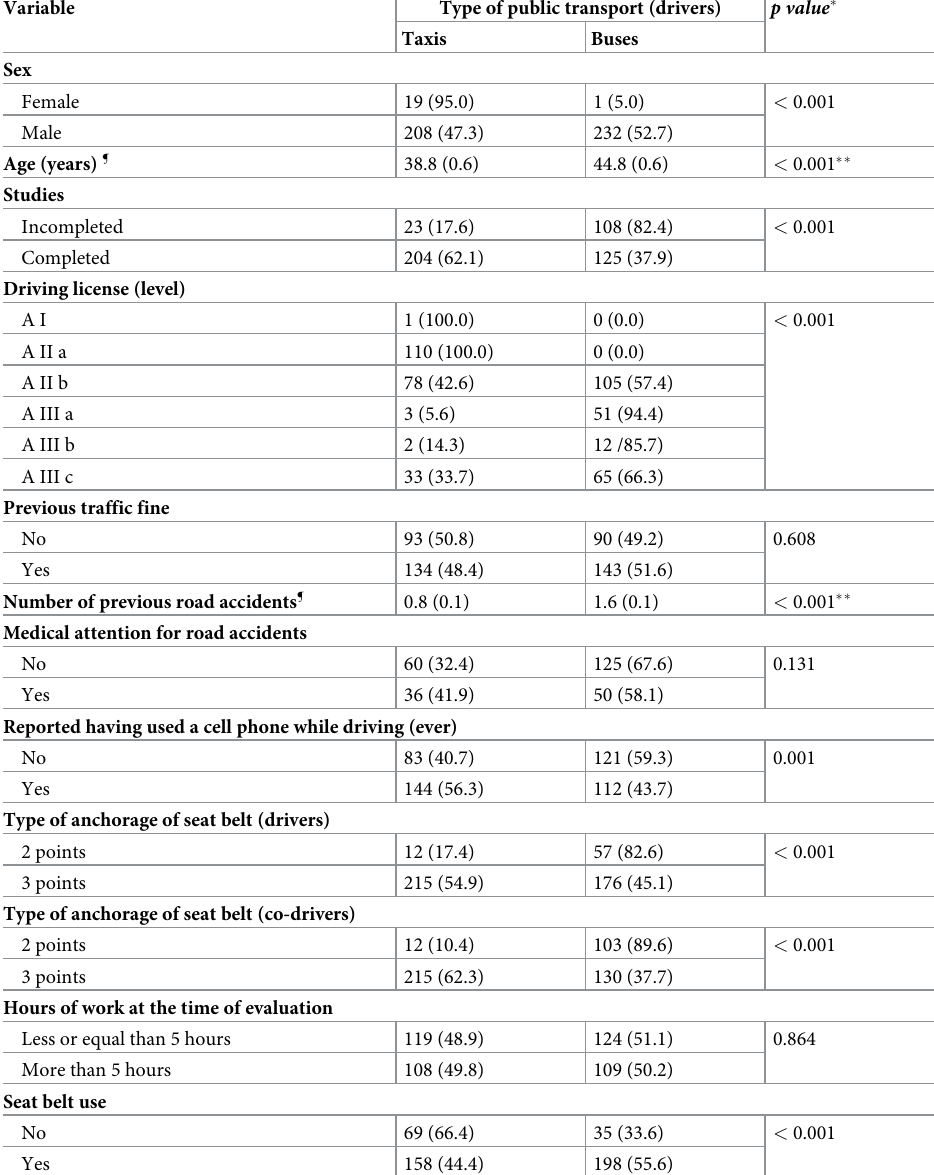
Table 2. Characteristics of the drivers according to the type of public transport in